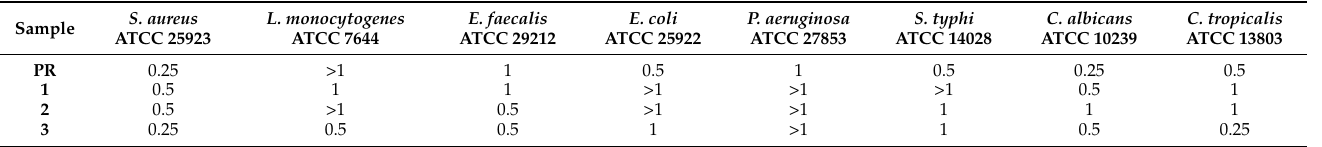
Table 7. Antimicrobial activity (MIC values in mg/mL) of propolis extract and isolated compounds.